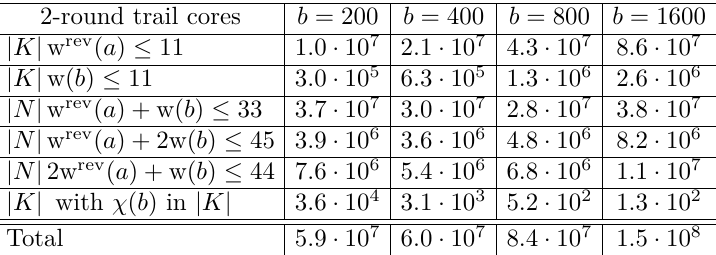
Table 7: Number of 2-round trail cores generated for each parity